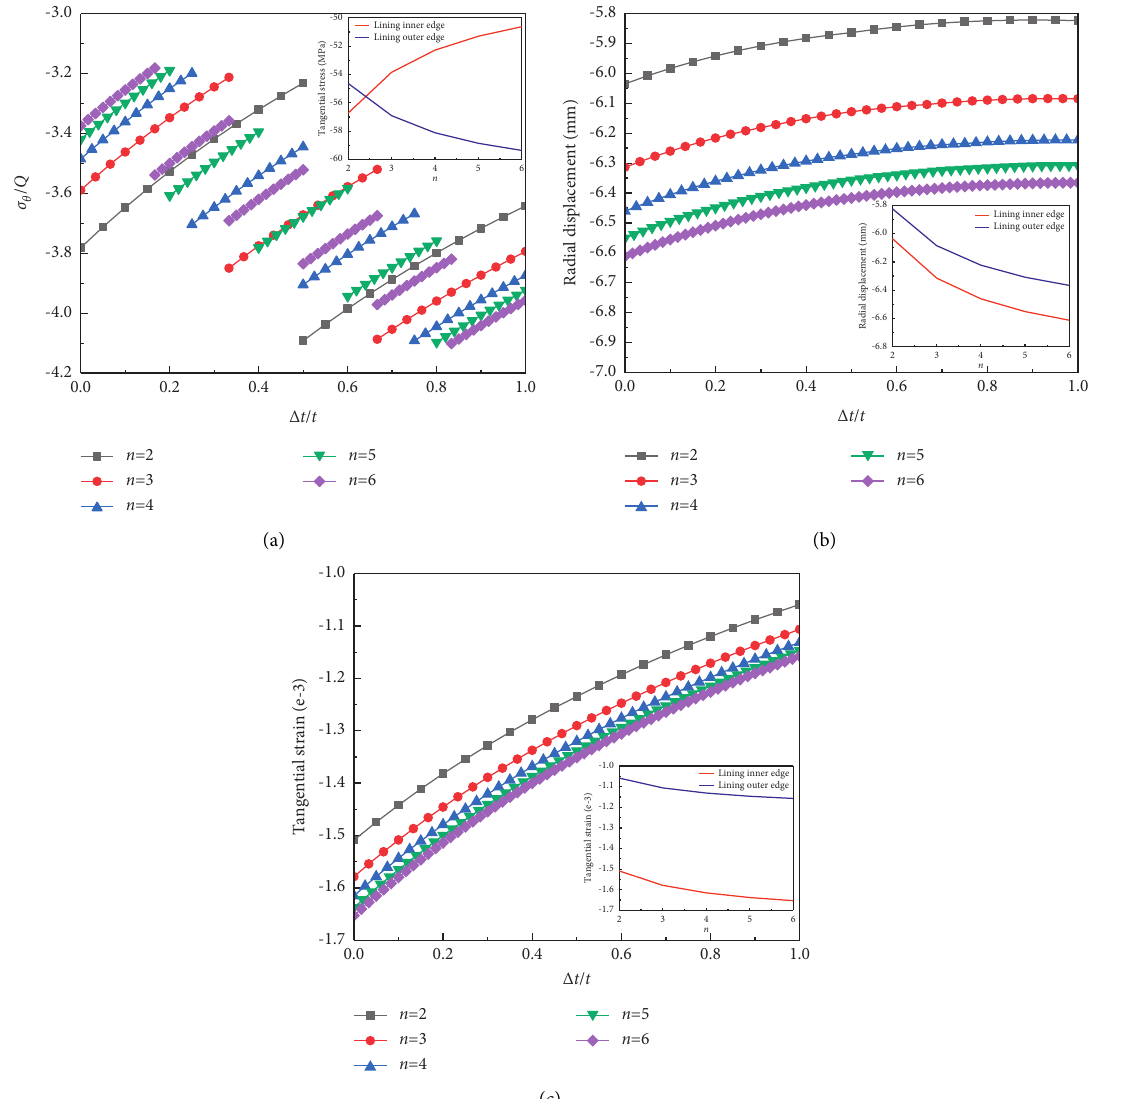
Figure 8: Variations in tangential stress, radial displacement, and tangential strain of FGL with the change in the number of layers n . (a) Tangential stress. (b) Radial displacement. (c) Tangential